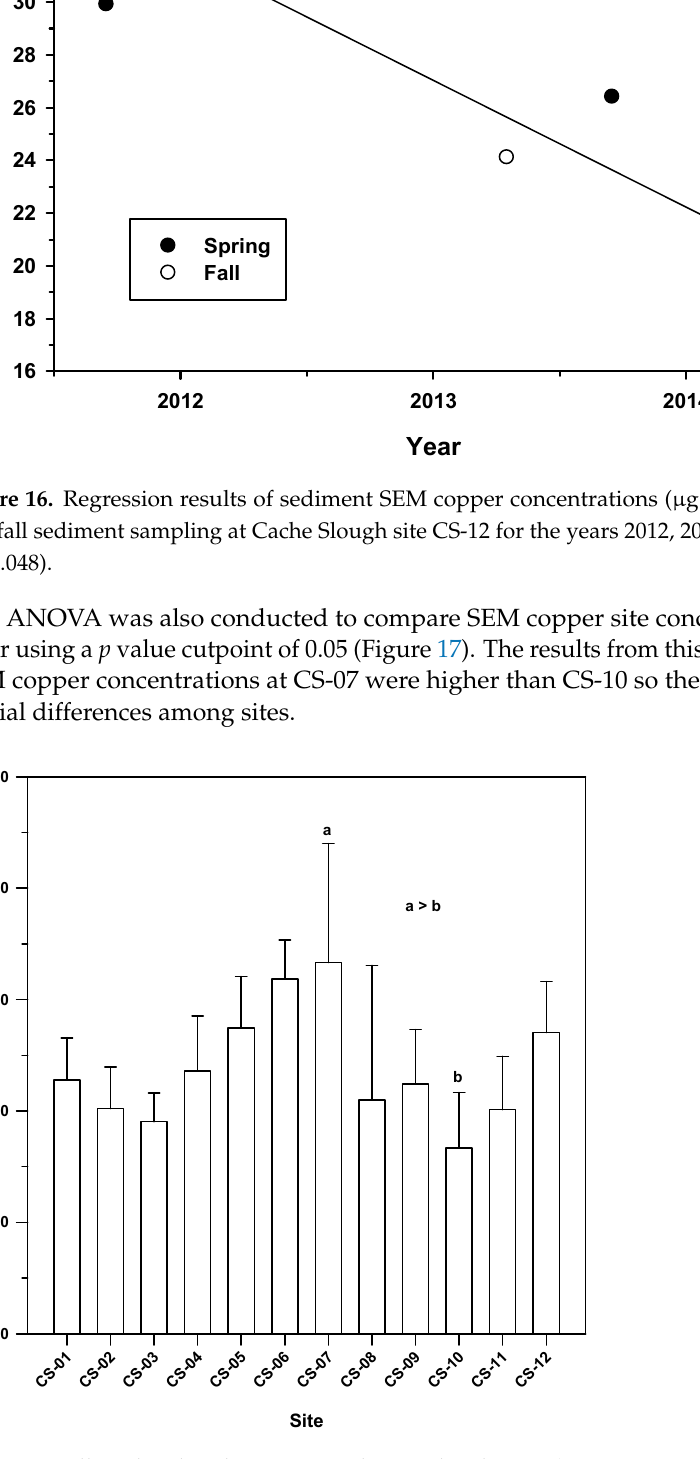
Figure 17. All Cache Slough SEM Cu sediment data by site (ANOVA, p = 0.005). a,b: Site CS-07 is significantly different from site CS-10 (Holm-Sidak method, p ≤ 0.050).